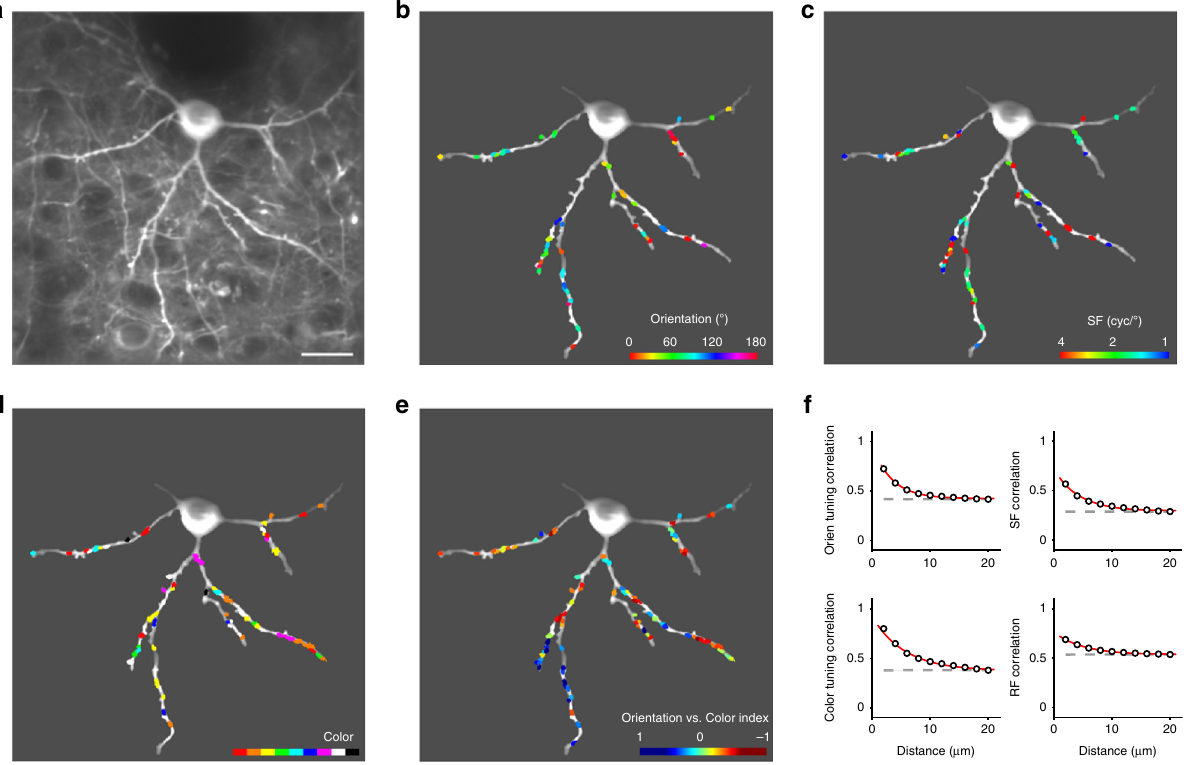
Fig. 2 The spatial organization of dendritic excitatory inputs on individual V1 neurons. a Two-photon image of an example neuron (depth of 127 μ m on Day 71 post-injection) expressing SF-iGluSnFR.A184S in V1 super fi cial layers. The image was averaged across 1000 frames. Scale bar, 20 µ m. b Map of orientation-selective ROIs on dendrites of the example neuron. Orientation preferences are colored for vector sum polarity for each ROI (refer to colorbar at the lower right). c Map of SF preferences of the orientation-selective inputs. SF preferences are colored for fi tting maximum for each ROI. d Map of color-selective inputs. Color preferences are labeled with the dominant polarity for each ROI. e A functional preference map of dendritic inputs. ROIs are colored for the orientation vs. color index. f Relationship between the dendritic distance of ROI pairs (18,581 ROI pairs in total from 23 neurons) and their tuning correlation coef fi cients (top left, orientation tuning correlation among orientation-selective ROIs; top right, SF tuning correlation among orientation- selective ROIs; bottom left, color tuning correlation among color-selective ROIs; bottom right, RF correlation among orientation-selective ROIs). Data points are fi tted with an exponential curve (red), and shuf fl ed data are presented as a reference (gray dashed). Error bar,